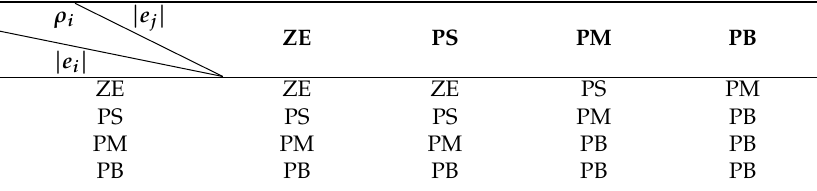
Table 1. Rule base for ρ i .